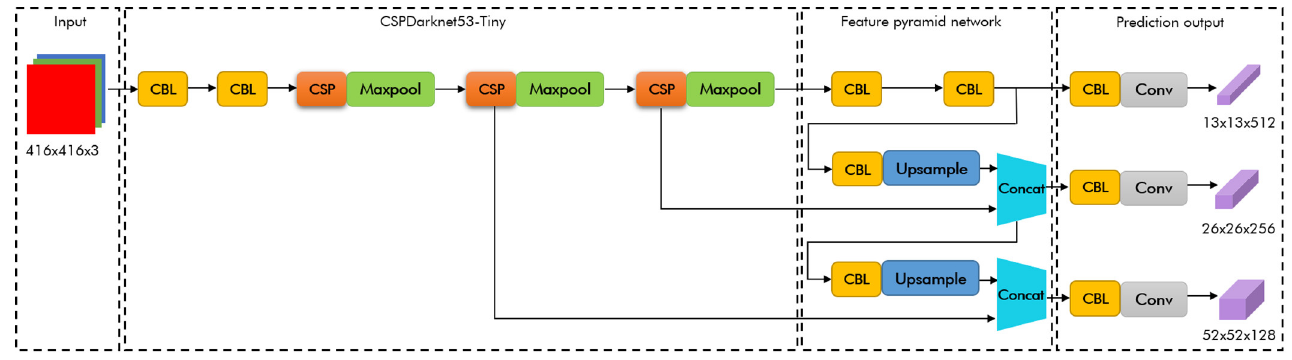
Figure 5. YOLOv4-tiny-3 network structure.